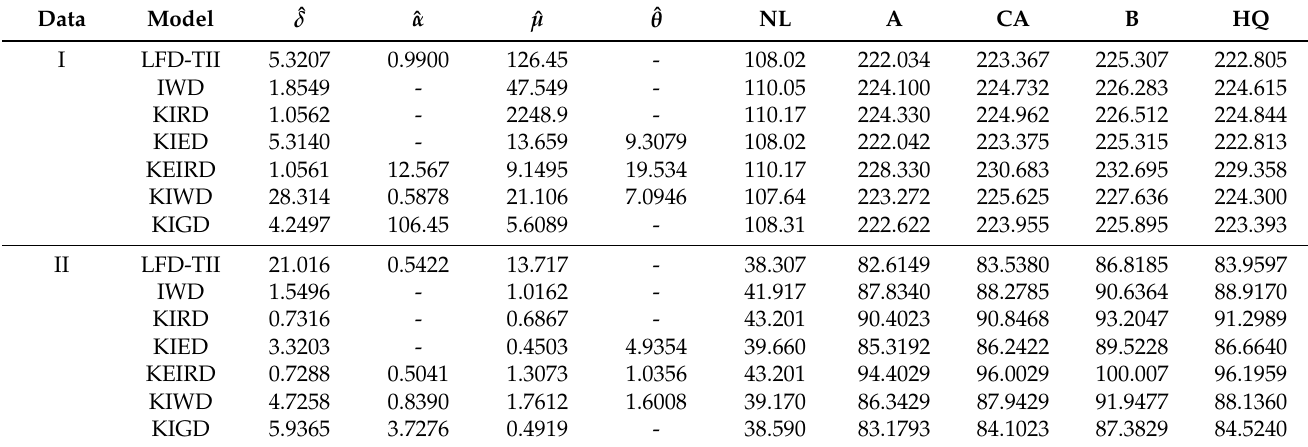
Table 3. Fitting results of the competitive models based on data sets I and II.